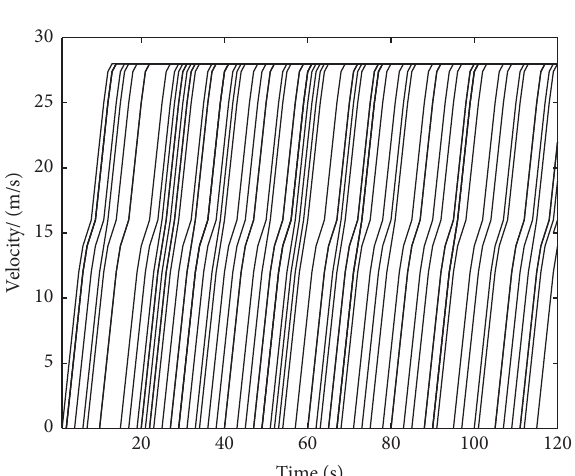
Figure 8: Velocity with enroute